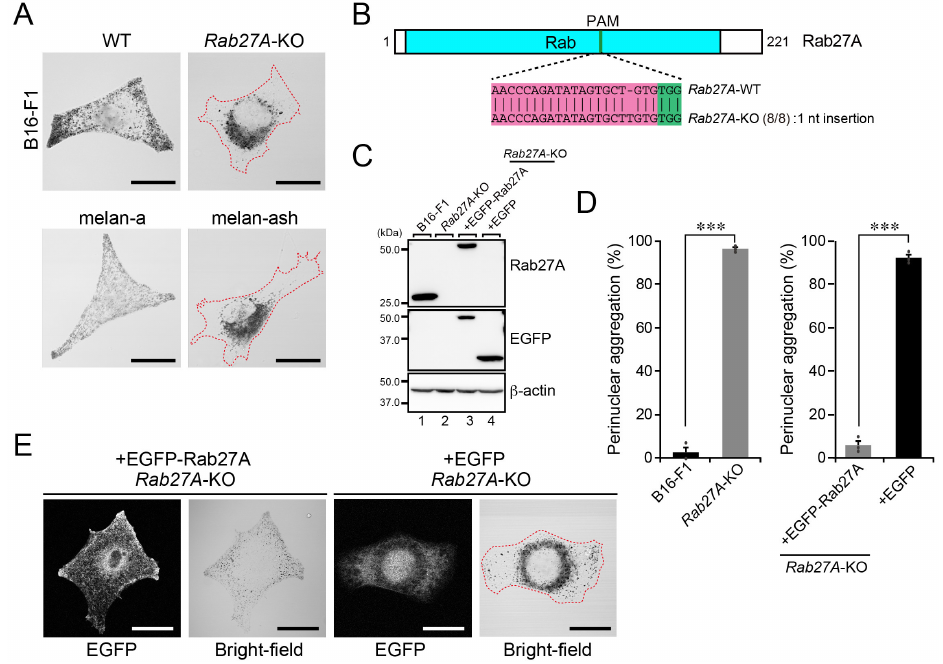
Figure 3. Rab27A is essential for the peripheral distribution of melanosomes. ( A ) Representative bright-field images of WT B16-F1 cells, Rab27A -KO B16-F1 cells, melan-a cells, and Rab27A-deficient melan-ash cells. Cells showing perinuclear melanosome aggregation are outlined with broken red lines. Scale bars, 20 µ m. ( B ) Domain organization of the mouse Rab27A protein and genomic mutations in Rab27A -KO cells. The Cas9 target and PAM sequences are highlighted in magenta and green, respectively. Genomic PCR products containing the target site were subcloned into the pGEM-T Easy vector. Then, eight colonies (denominators of the fractions in parentheses) were picked up at random and their inserts were sequenced. ( C ) Expression of Rab27A in WT cells and Rab27A -KO B16-F1 cells. Lysates of the cells indicated were analyzed by immunoblotting with antibodies against Rab27A (top), GFP (middle), and β -actin (bottom). ( D ) Quantification of the numbers of WT cells, Rab27A -KO cells, Rab27A -KO cells expressing EGFP-Rab27A, and Rab27A -KO cells expressing EGFP with perinuclear melanosome aggregation shown in ( A , E ). The graphs show the means and SEM of the data obtained in three independent experiments ( n > 24 cells in each experiment). ***, p < 0.001 (Student’s unpaired t -test). ( E ) Representative bright-field images of Rab27A -KO cells expressing EGFP-Rab27A or EGFP alone. The EGFP-expressing cell is outlined with a broken red line. Scale bars, 20 µ